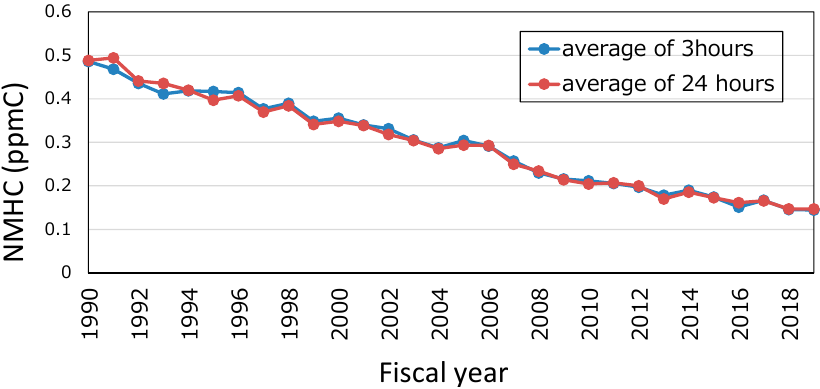
Figure 23. Trend in the annual averages of non-methane hydrocarbons (NMHC). Average of 3 h: annual averages of 3 h average of NMHC from 6 a.m. to 9 a.m. at seven General sta. (Daishi, Tajima, Kawasaki, Saiwai, Nakahara, Takatsu, and Tama). Average of 24 h: annual averages of 24 h average of NMHC concentrations from 12 a.m. to 12 a.m. at seven General sta.